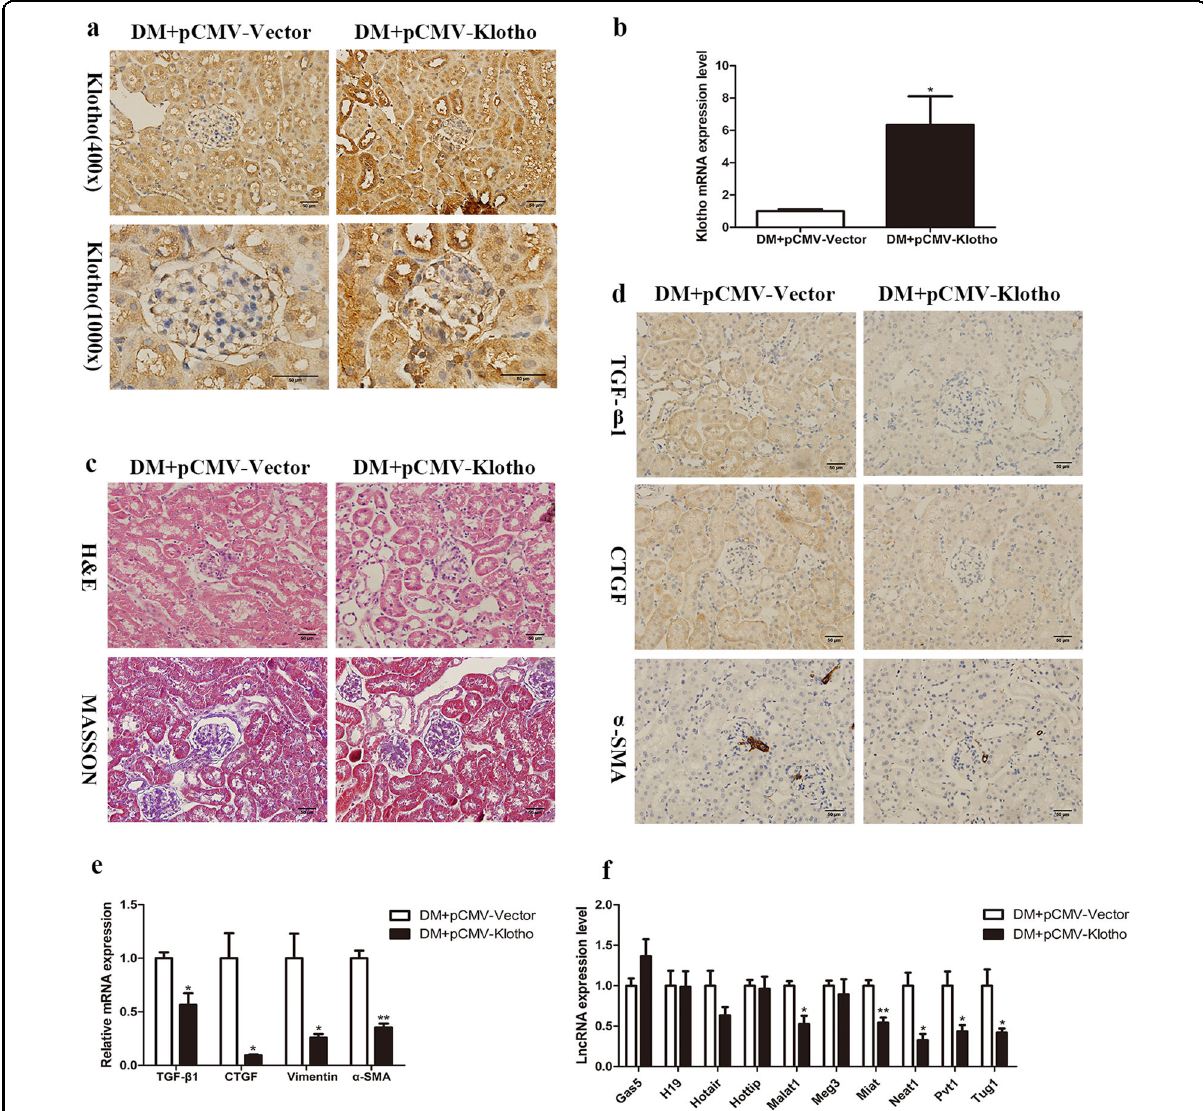
Fig. 1 Klotho represses lncRNA Neat1 expression in DM mice. Diabetic model mice established with HFD and STZ induction were transfected with Klotho plasmids by hydrodynamic transfection in vivo. a , b Immunohistochemistry and qRT-PCR were performed to determine the Klotho expression level in the renal tissues of Klotho-overexpressing DM mice. c H&E staining and Masson ’ s trichrome staining were performed to investigate the protective effect of Klotho on the kidneys of diabetic mice (magni fi cation, ×400). d , e Immunohistochemistry and qRT-PCR were performed to determine the TGF- β 1, CTGF, vimentin and α -SMA expression levels in Klotho-overexpressing DM mice (magni fi cation, ×400). f qRT-PCR was performed to determine the levels of long noncoding RNAs (lncRNAs) in Klotho-overexpressing DM mice. Values are the mean ± SEM. * p < 0.05 vs DM + pCMV-vector, ** p < 0.01 vs DM + pCMV-vector, *** p < 0.001 vs DM +